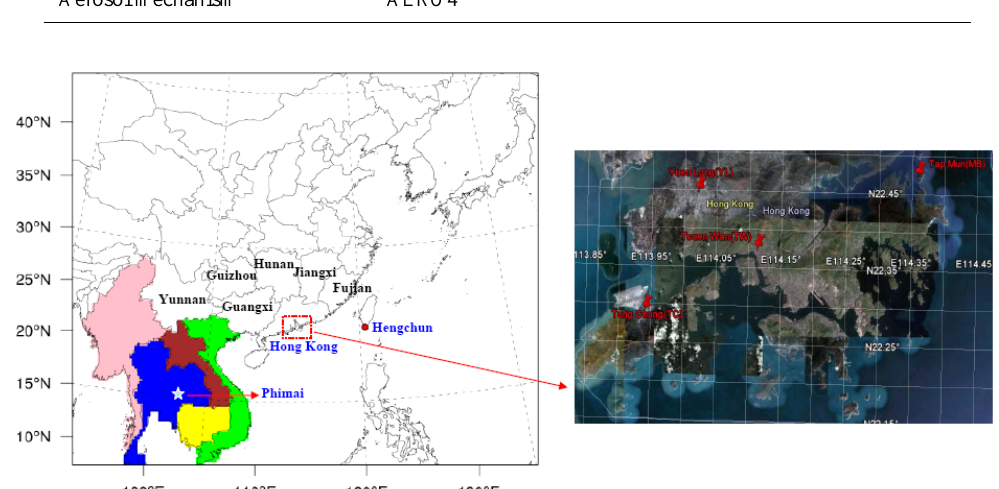
Figure 1. The 27×27 km nested domain from the mother domain with a resolution of 81×81 km. Five countries with dominant biomass burning emission in Southeast Asia in this study are colored (Pink: Burma; Bule: Thailand; Yellow: Cambodia; Red: Laos; Green: Vietnam). The observational sites used in this study for model performance are also plotted in the figure, including one site in Thailand (Phimai), four sites in Hong Kong ( Tsuen Wan, Yuen Long, Tap Mun and Tung Chung ) and one site in Taiwan (Hengchun).